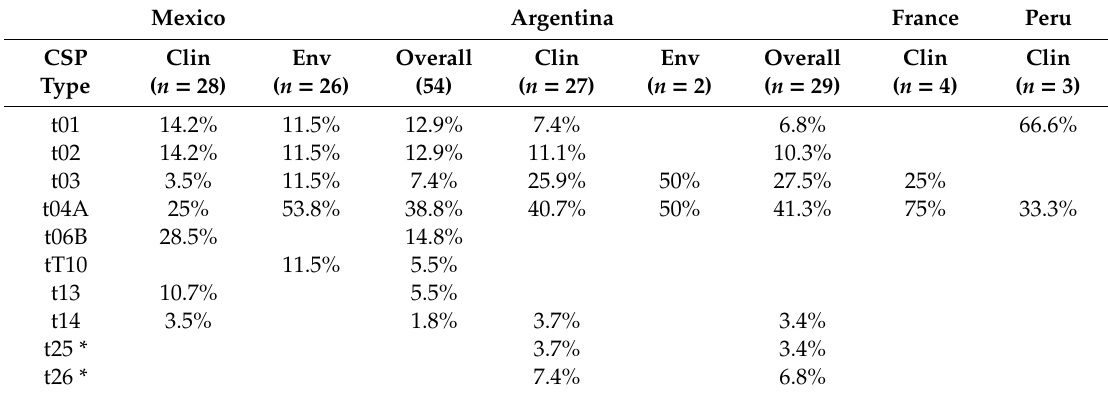
Table 5. Prevalence of CSP types in A. fumigatus isolates from Mexico, Argentina, France, and Peru. Mexico